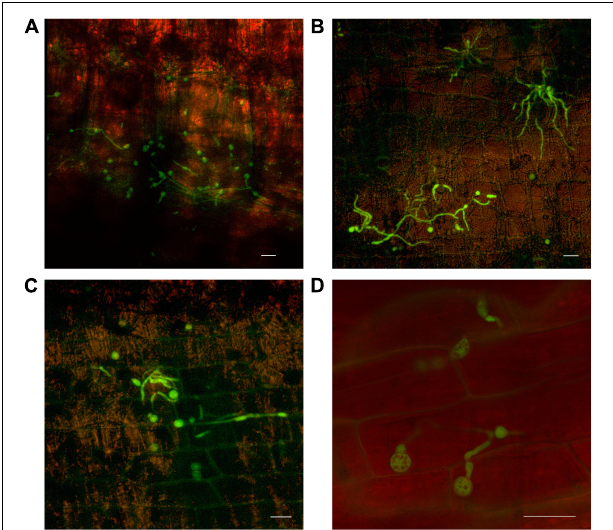
FIGURE 6 | Confocal microscopy highlighting the development of chlamydospores of fluorescing Fusarium oxysporum f.sp. cubense in decaying leaf sheaths of Lady Finger and Cavendish banana plants. (A) Cavendish pseudostem at 40 dpi at 0–5 cm above the rhizome showing chlamydospores present in the gas spaces of leaf sheath. (B,C) Cavendish pseudostem at 80 dpi at 5–10 cm above the rhizome showing chlamydospores present on the outside of the leaf sheath. (D) Lady Finger pseudostem at 70 dpi at 0–5 cm above rhizome showing the chlamydospores present in decaying leaf sheath. Scale bars represent 20 µ m.